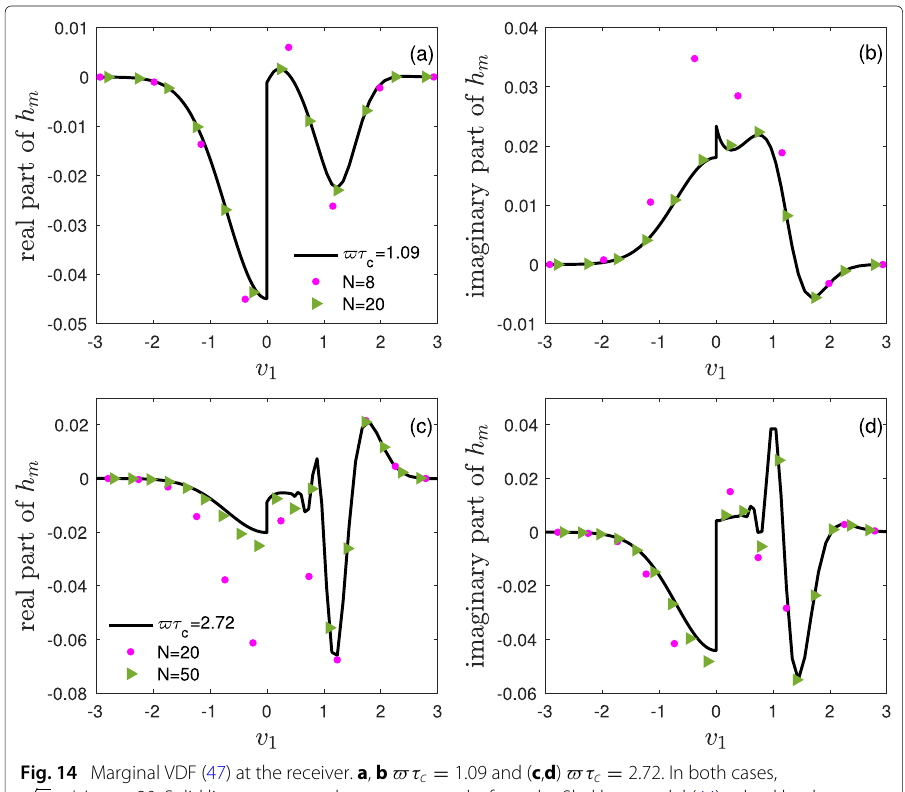
Fig. 14 Marginal VDF (47) at the receiver. a , b (cid:15)τ c = 1.09 and ( c , d ) (cid:15)τ c = 2.72. In both cases, √ π(cid:15) L / v = 20. Solid lines represent the accurate results from the Shakhov model (44) solved by the m discrete velocity method [69], while symbols are approximate solutions of the Shakhov model when the molecular velocity space v is discretized according to the Gauss-Hermite quadrature of order N